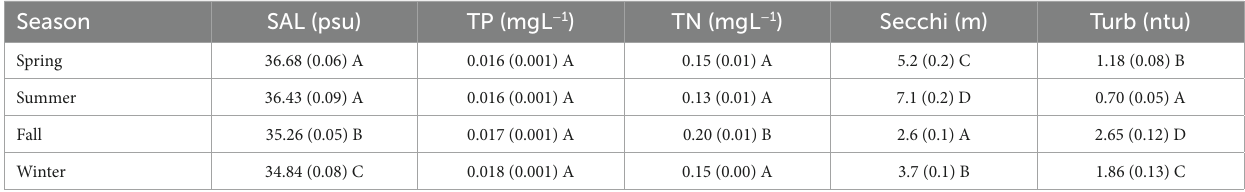
TABLE 1 Mean seasonal values for physical and chemical variables for different seasons with the standard error in paratheses.